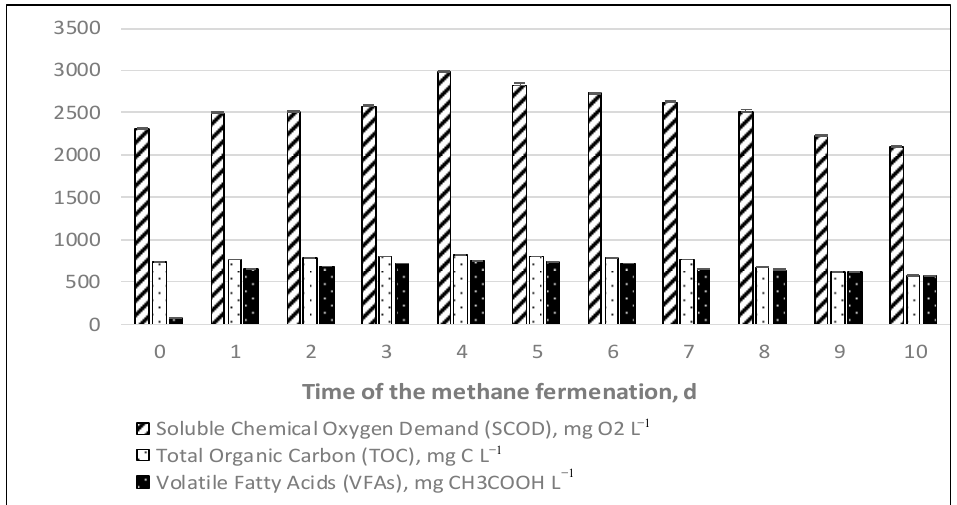
Figure 6. Changes of SCOD, TOC, and VFAs values in the methane fermentation process of sonicated excess sludge.